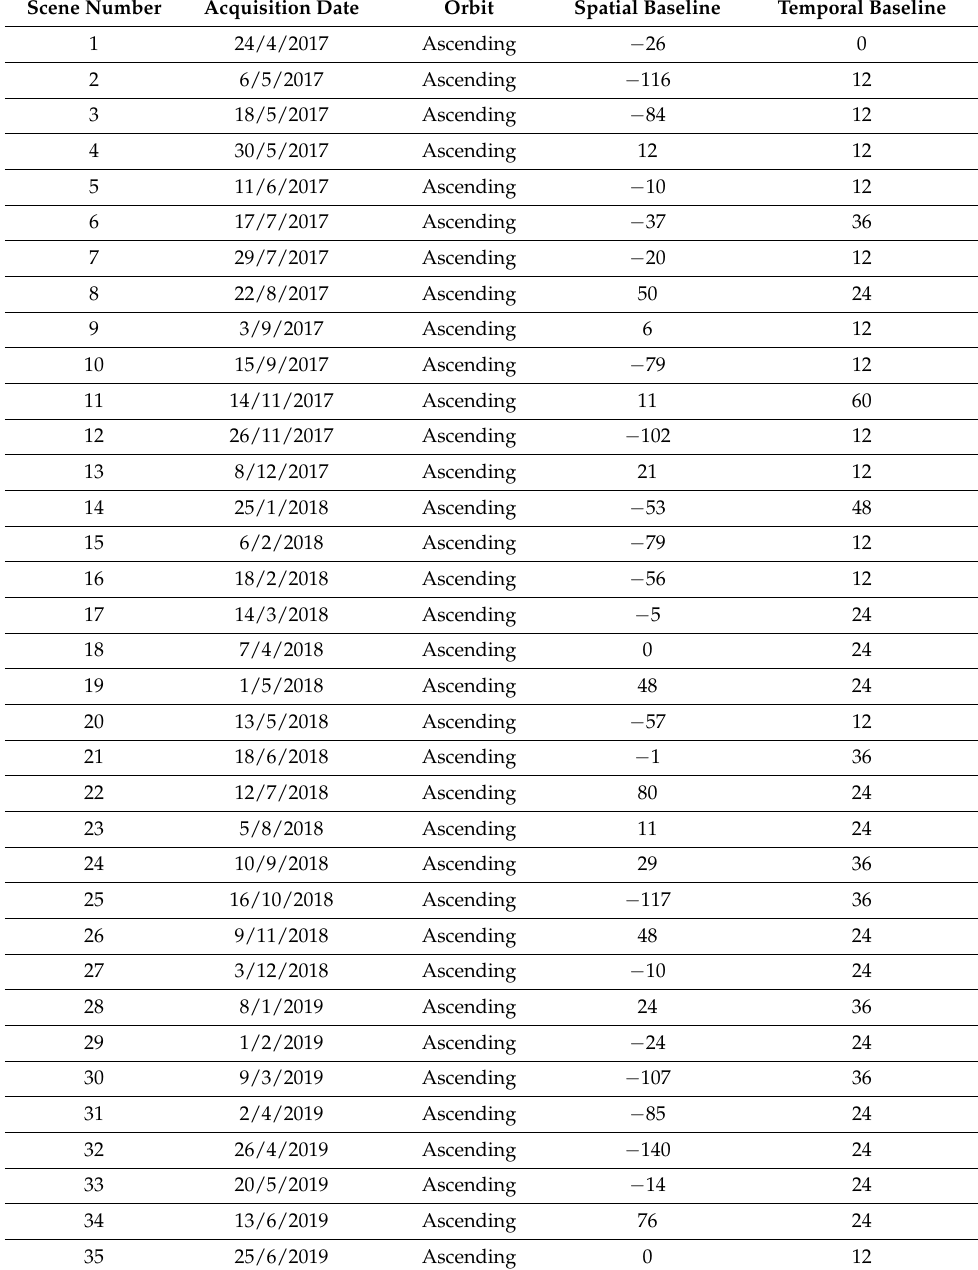
Table A1. List of SAR scenes used in the southern stack for subsidence